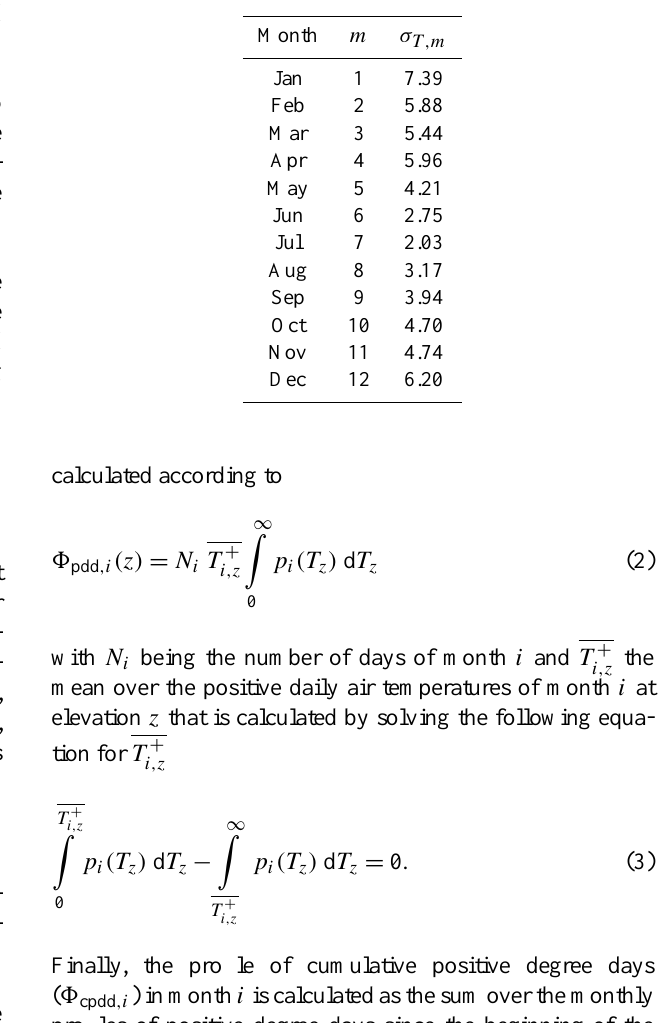
Table 1. Mean standard deviations of daily air temperature ( σ T,m ) within the specific months m of the annual cycle. Values are long- term means that are calculated from the downscaled daily ERA- Interim air temperatures of the period 2000–2008. Unit is ◦